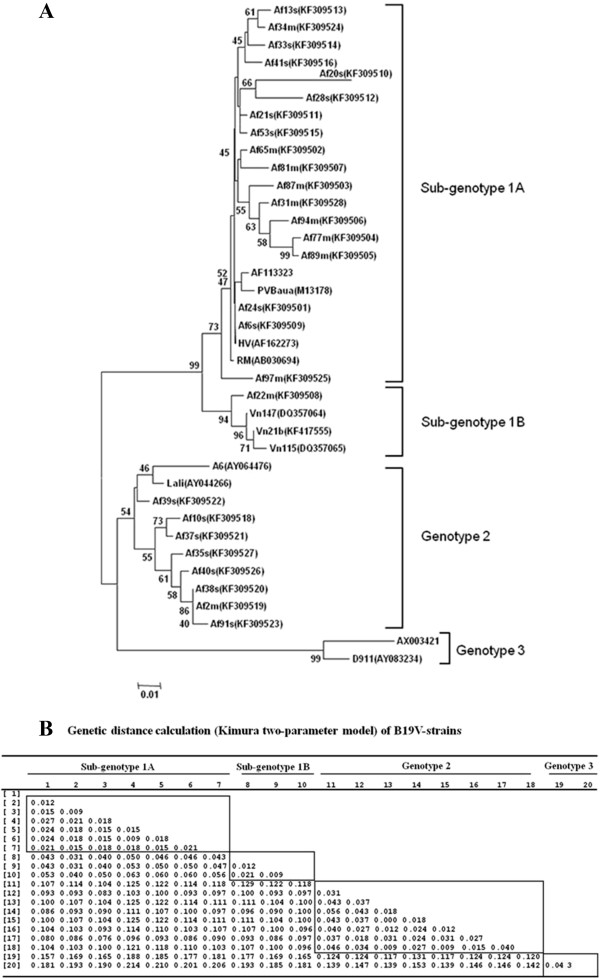
Phylogenetic analysis of the B19V-NS1/VP1u region. (A) The phylogenetic tree has been inferred from the B19V-NS1/VP1u region (nt 2355 to nt 2690) of 39 B19V-samples. Topology was constructed by MEGA 5.0 software using the Neighbor-joining method with bootstrap values (in percent) indicating numbers from 1,000 replicates tested (values <40 were not shown). Major lineages of B19V are shown as branches. The two major B19V-subtypes 1A and 1B are shown [31]. Scale bar at bottom indicates the number of nucleotide substitutions per site. Patient codes and the corresponding GenBank accession number are denoted (e.g., Af31m(KF309528)). Reference B19V-sequences were GenBank accession No. AB030694, AF113323, M13178 and AF162273 for B19V-genotype 1A, DQ357064, DQ357065, and KF417555 for B19V-genotype 1B, AY064476 and AY044266 for B19V-genotype 2, and AX003421 and AY083234 for B19V-genotype 3. (B) Genetic distance calculation (Kimura two-parameter model) of B19V-strains. Numbers at the left denote patient-specific B19V-strains and B19V-reference strains [Genbank numbers are denoted]: [1] M131178; [2] AB030694; [3] Af21s (KF309511); [4] Af13s (KF309513); [5] Af33s (KF309514); [6] Af34m; [7] Af41s (KF309516); [8] Af22m (KF309508); [9] DQ357064; [10] DQ357065; [11] AY064476; [12] AY044266; [13] Af2m (KF309519); [14] Af37s (KF3095021); [15] Af38s (KF3095020); [16] Af35s (KF3095027); [17] Af39s (KF3095022); [18] Af40s (KF3095026); [19] AY083234; [20] AX003421. B19V-reference strains are genotype 1: [1], [2], genotype 2: [11], [12], and genotype 3: [19], [20]. Boxes represent data of the genetic distance calculation of the same genotype and sub-genotype.